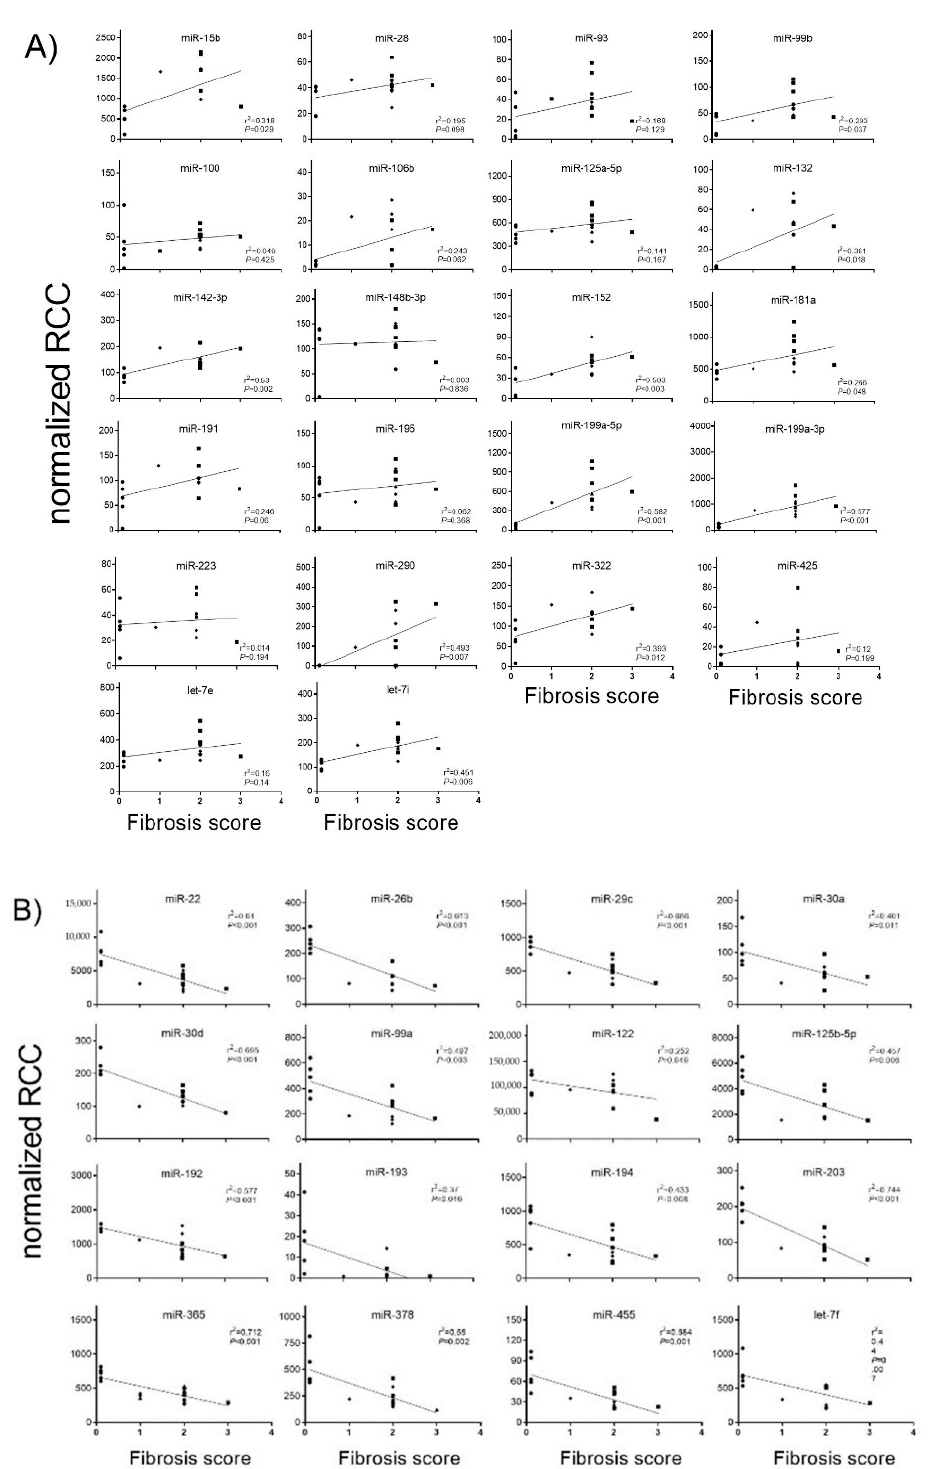
Figure 3. Correlation of fibrosis scores with up-regulated hepatic ( A ) and down-regulated ( B ) miRNA expression. MiRNA levels of control, CCl 4 /Vehicle and CCl 4 /PDE5 inhibitor treated rats were correlated with fibrosis scores. Absolute values are displayed for each animal by normalized reporter cell counts (RCC). Spearman’s correlation coefficient and corresponding p -values are